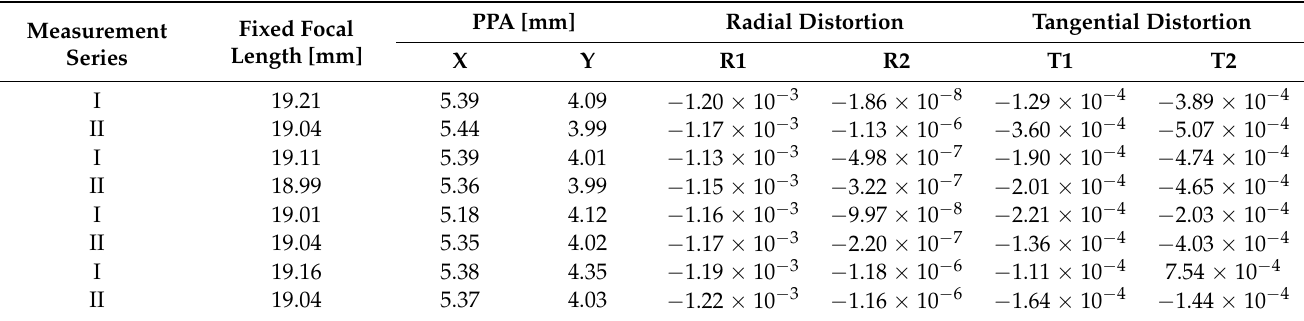
Table A3. Analysis of the influence of image geometry on calibration